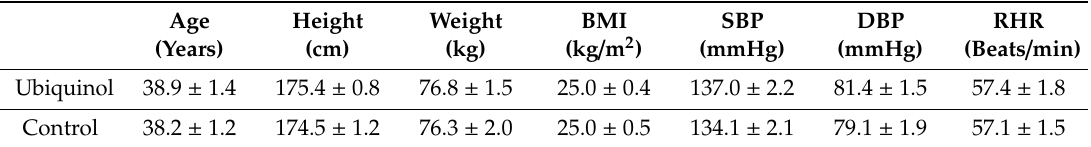
Table 1. Subjects baseline